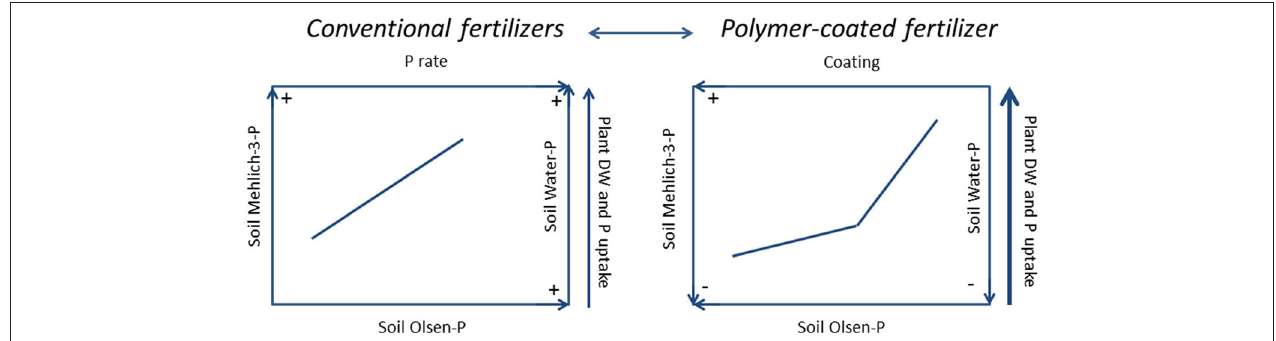
FIGURE 4 | Summary chart. The picture depicts the results from conventional P fertilizers (single superphosphate and mono-ammonium phosphate) (LEFT) vs. polymer-coated mono-ammonium phosphate (RIGHT) on soil Olsen-P, Mehlich-3-P on water-P, on plant dry weight (DW) and on P uptake after 45 d from the treatment. The arrows should facilitate making sense of the path. On the left, at the increasing of P fertilizer rate, soil Olsen-P, Mehlich-3-P, water-P, plant DW and P uptake all increased. On the right, at the increasing of coating, soil Olsen-P, Mehlich-3-P and water-P decreased, whereas plant DW and P uptake increased. Overall, the soil P pools extracted after the treatment with polymer-coated mono-ammonium phosphate were lower than those from conventional fertilizers.